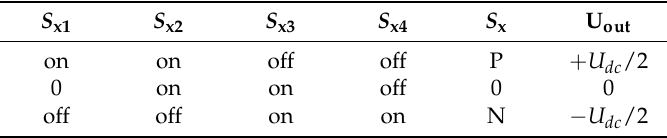
Table 1. Switching states in one phase of the inverter.